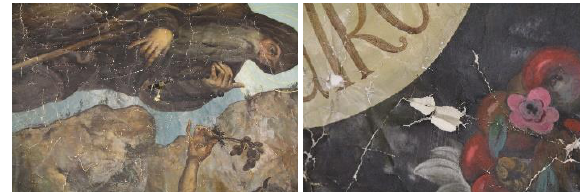
Figure 8 – Examples of superficial laceration on banners S. Antão (left) and S. Gonçalo (right)